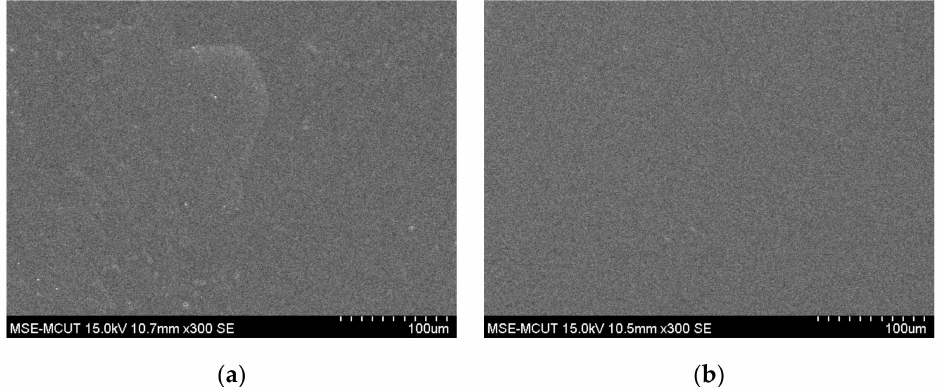
Figure 4. Surface morphology SEM images of screen-printed UV-curable paste on the wound- dressing: ( a ) one pass and ( b ) two passes.